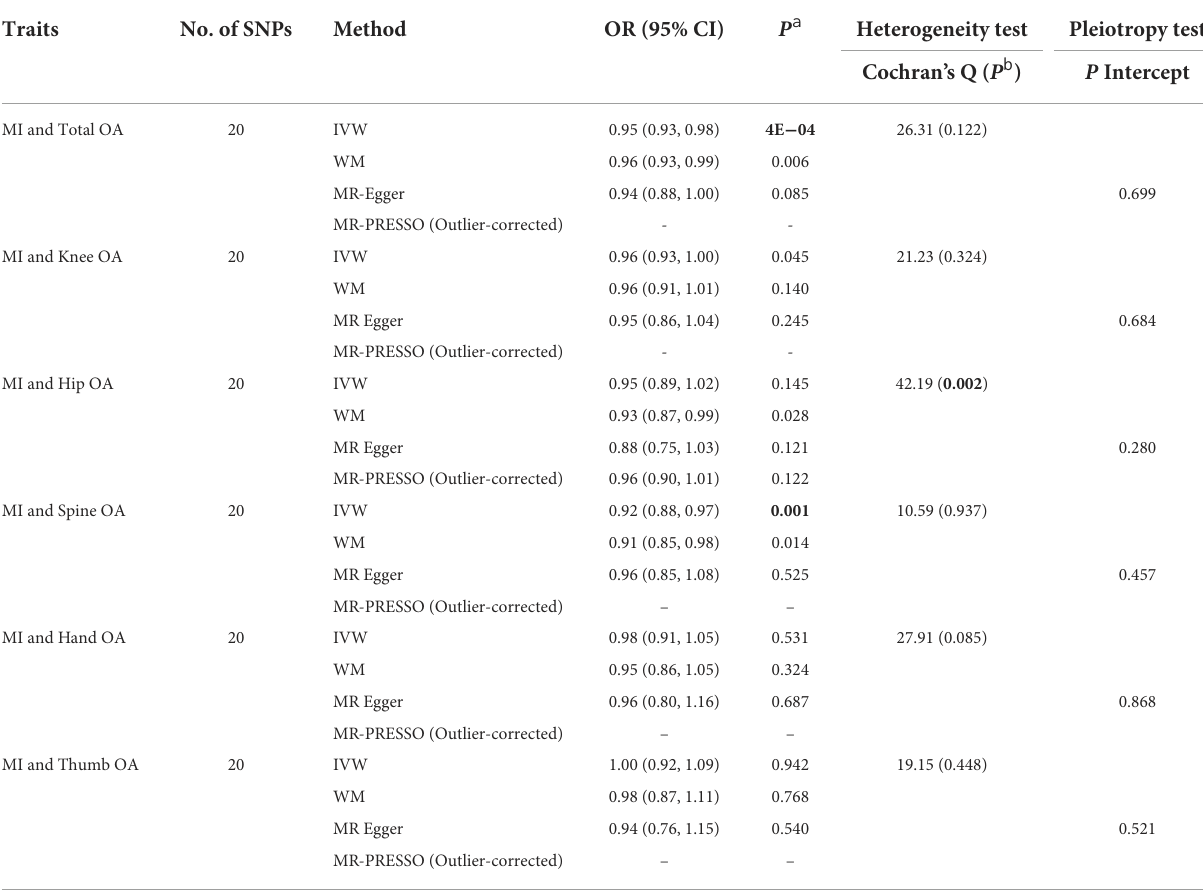
TABLE 5 MR results of the association between MI and OA.